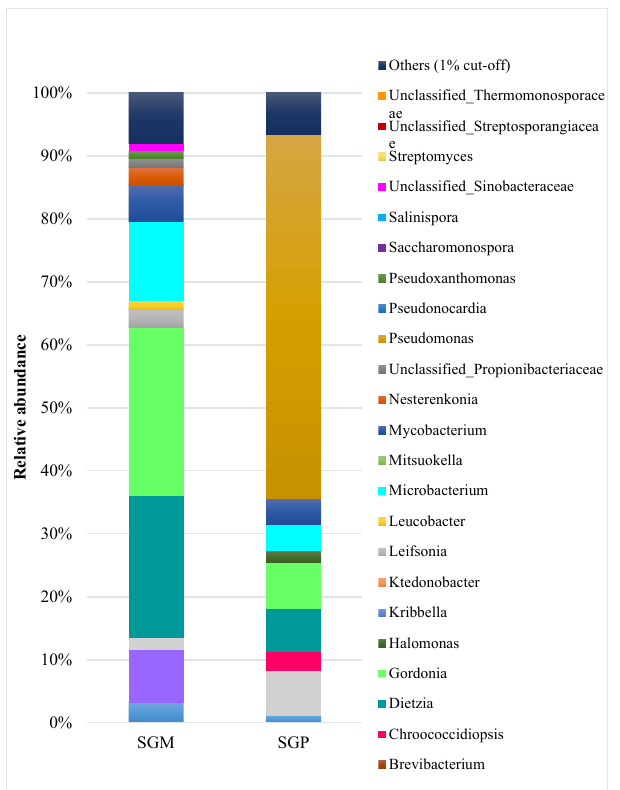
Figure 1. Relative abundance of the taxa at the genus level in the soil samples of the two sites SGM and SGP. Only taxa with at least 1% relative abundance are represented. The rest are grouped in the